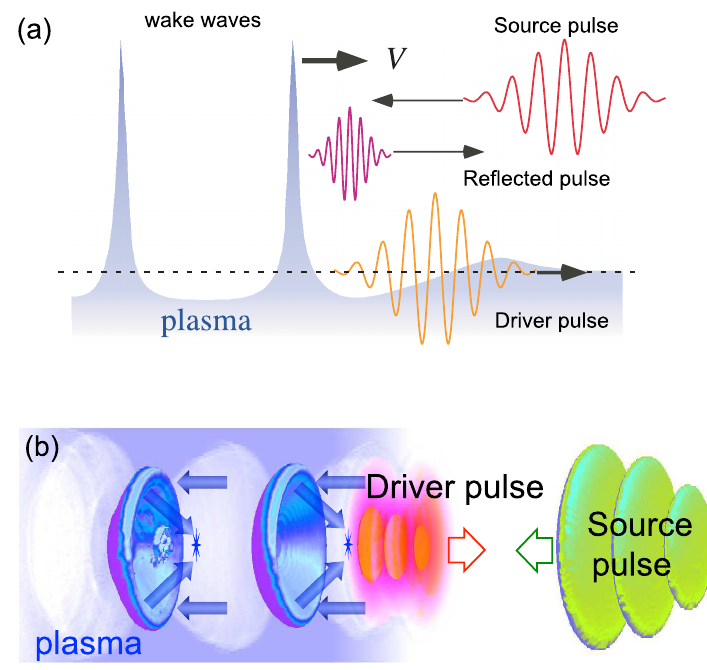
Figure 3. Relativistic flying mirrors of breaking plasma waves showing one dimensional ( a ) and three dimensional ( b ) representations.